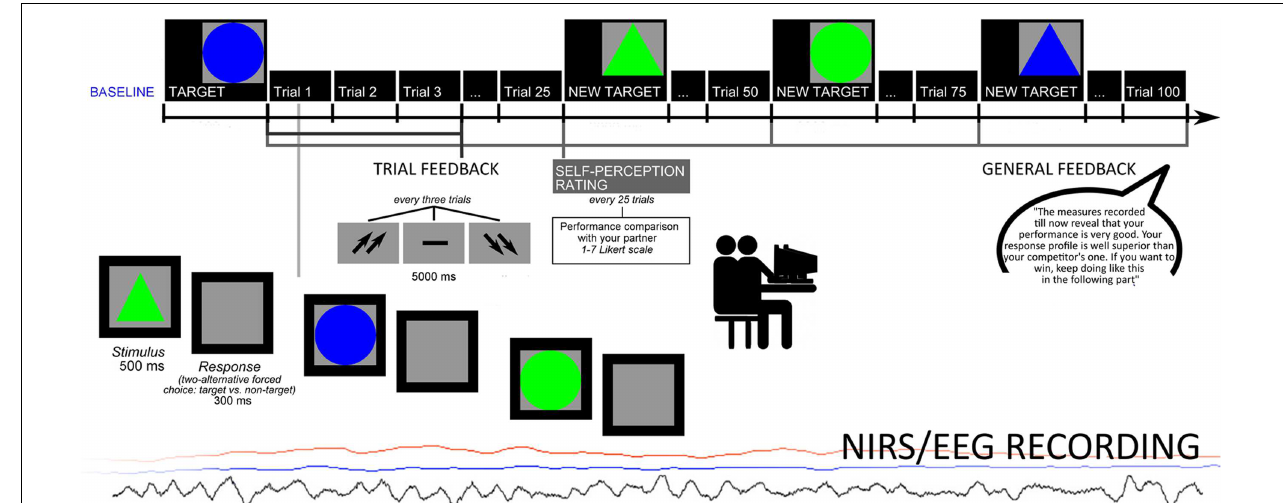
FIGURE 1 | Experimental procedure which represents setting, task, and measure